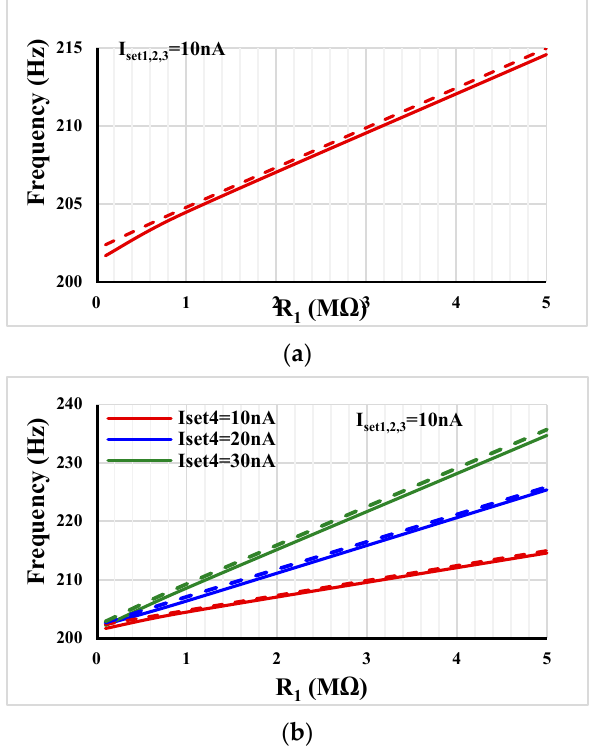
Figure 9. Frequency tuning capability of the shadow oscillator: ( a ) Figure 4a, ( b ) Figure 4b ( V o2 dashed line).